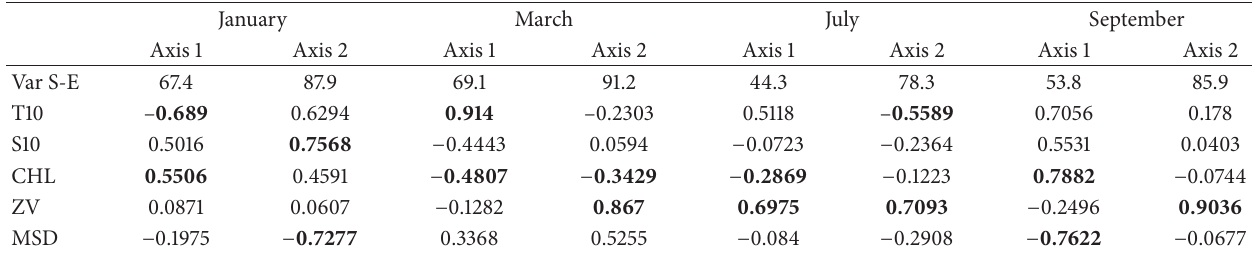
Table 2: Summary of the redundancy analysis (RDA) applied to fish larvae abundance and environmental variables in each